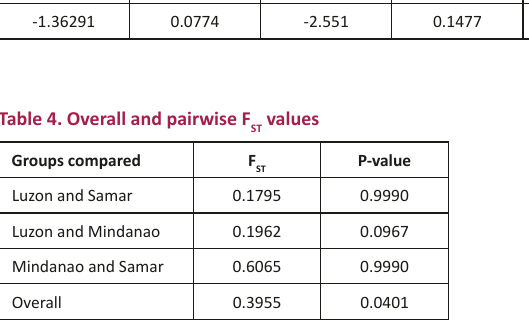
of the control region. F